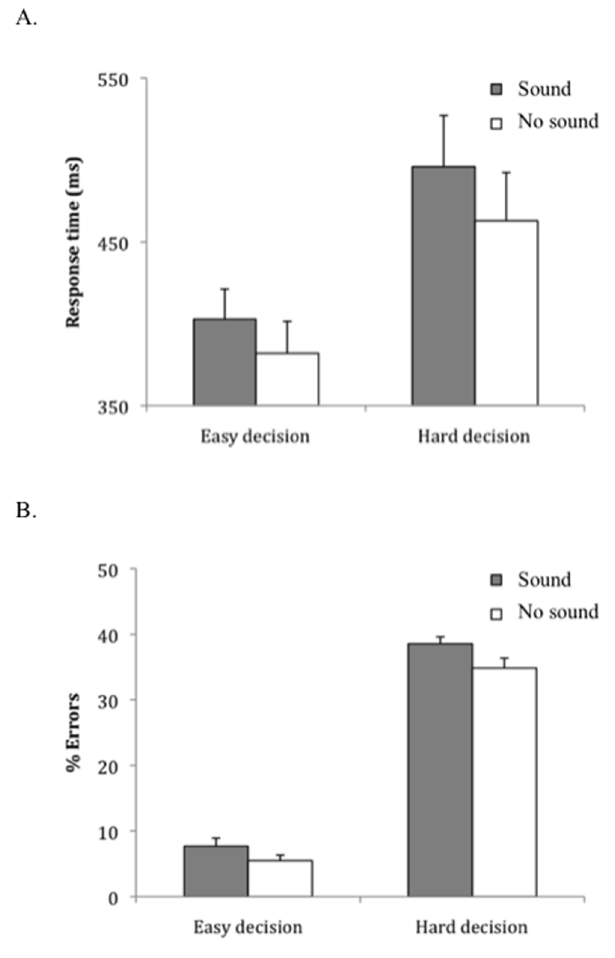
Figure 1. Response times and errors to easy- and hard-shot decisions when sound was or was not present. Dark grey bars represent when the sound was present and clear bars when the sound was absent for easy- and hard-shot decisions (A – response time and standard error bars in ms; B – total percentage and standard error bars of decision errors). All differences are significant.